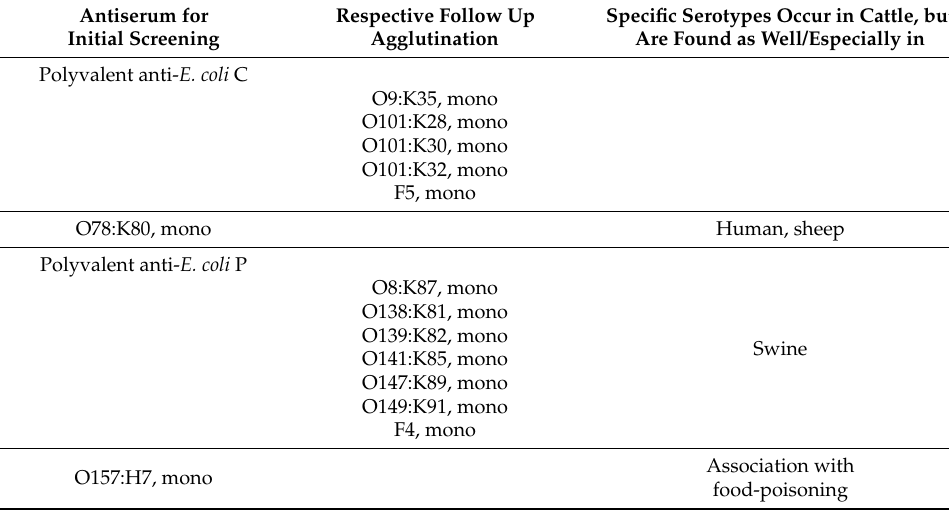
Table 3. In all, 16 different polyvalent and monovalent (mono) antisera were used for the agglutination and the characterization of E. coli . The listed serotypes are known for their pathogenicity in humans and farm animals. Antiserum for Respective Follow Up Specific Serotypes Occur in Cattle, but Initial Screening Agglutination Are Found as Well/Especially in Polyvalent anti- E. coli